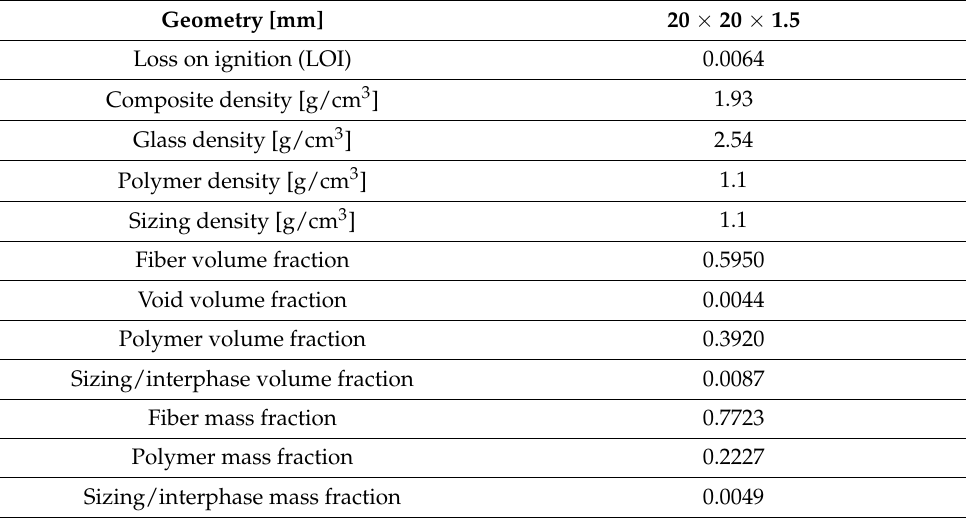
Table 1. GFRP plate specimen